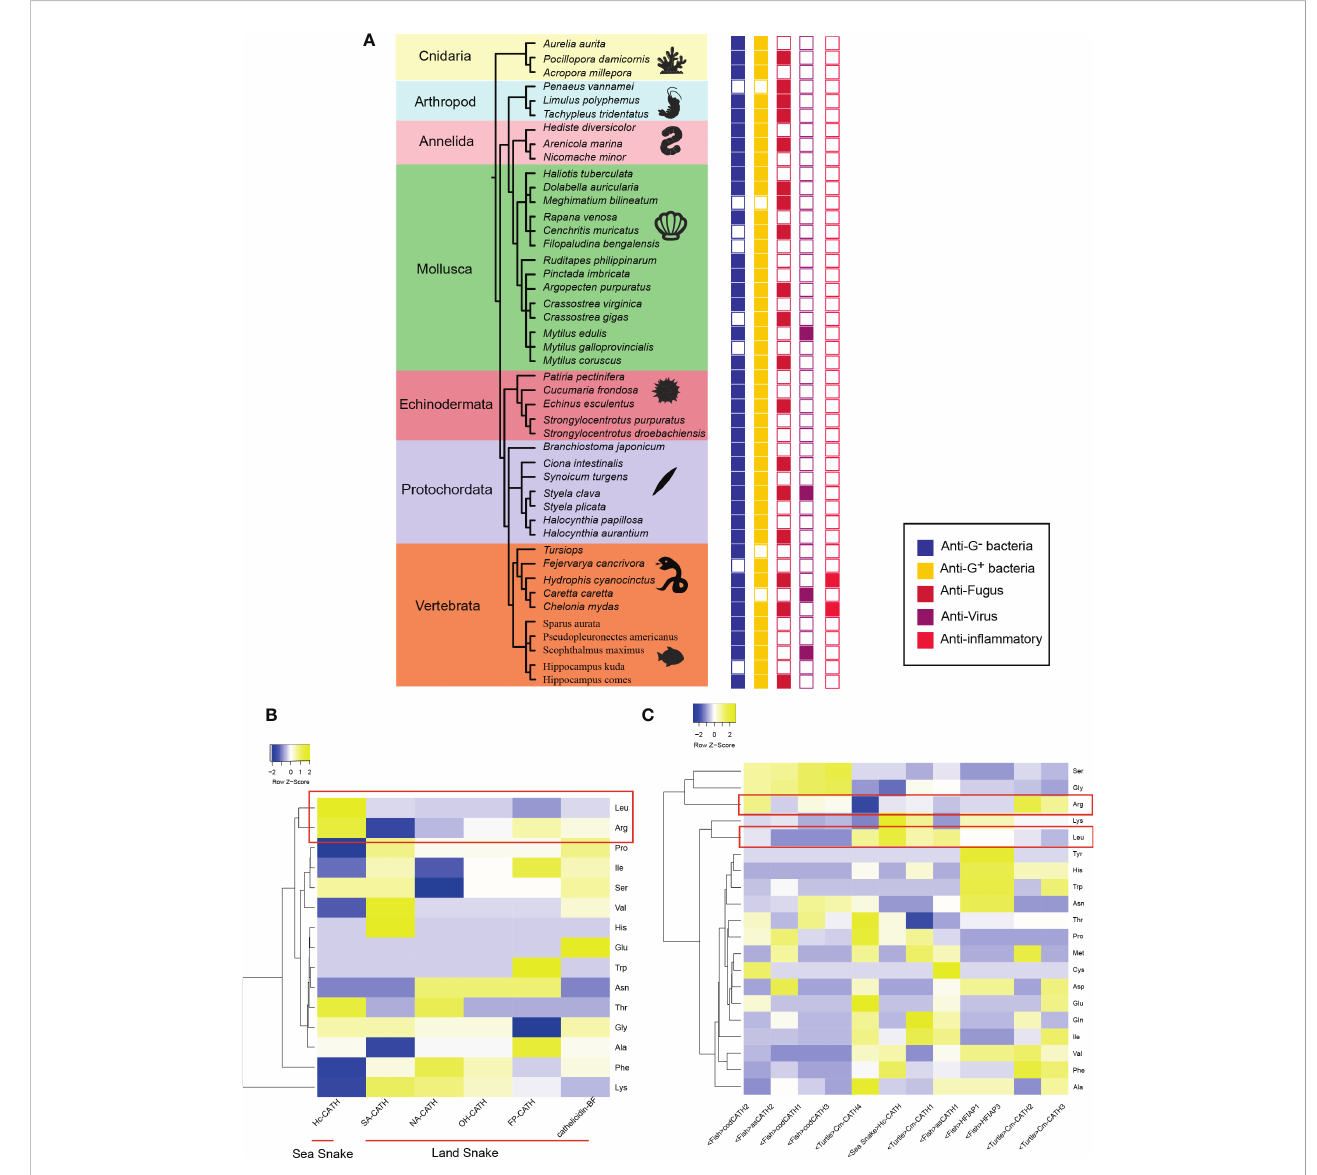
FIGURE 1 Activity and characteristic of marine AMPs (A) shows the activity of marine AMPs. The color of boxes from left to right correlates with activity for Gram- negative, Gram-positive, fungus, virus, and in fl ammatory. Empty squares indicate no activity or activity has yet been found. (B) is the results of comparison between sea snake AMPs and land snake AMPs. Color represents contents about different amino acids in AMP. (C) exhibits the comparison of marine AMPs. Hc, Hydrophis cyanocinctus ; SA, Trimerodytes annularis ; NA, Naja atra ; OH, Ophiophagus hannah ; FP, Deinagkistrodon acutus ; BF, Bungarus fasciatus; Cm, Chelonia mydas ; as, Salmo salar ; cod, Gadus morhua ; HFI, Myxine glutinosa